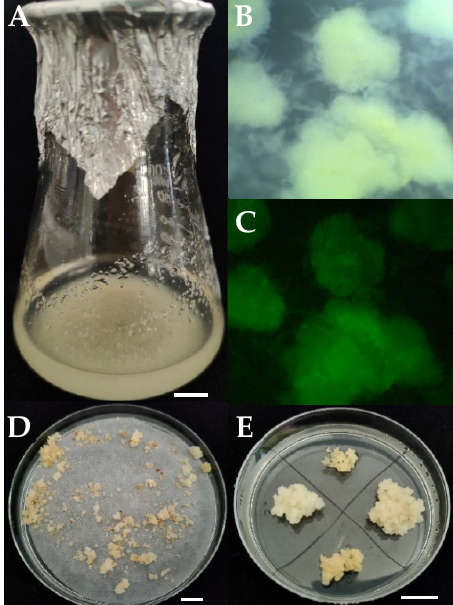
Figure 1. Subsequent stages of the wheat cell suspension transformation: ( A )—an established suspension cell culture; ( B )—cell aggregates; and ( C )—a transient GFP expression 48 h after A. tumefaciens inoculation (36× magn.); ( D )—primary growth of transgenic cell lines after 3 weeks on solid selection medium; ( E )—proliferation of selected cell lines on solid selection medium. Bar 1 cm.